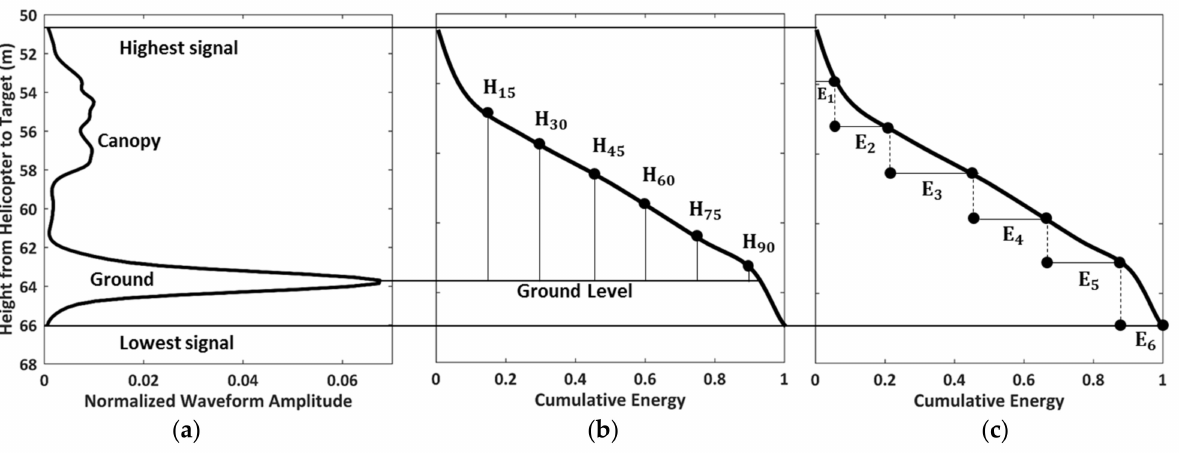
Figure 3. The illustrations of the waveform and the resultant cumulative energy, which determine the height percentiles and energy percentiles. ( a ) original waveform; ( b ) height percentiles; ( c ) energy